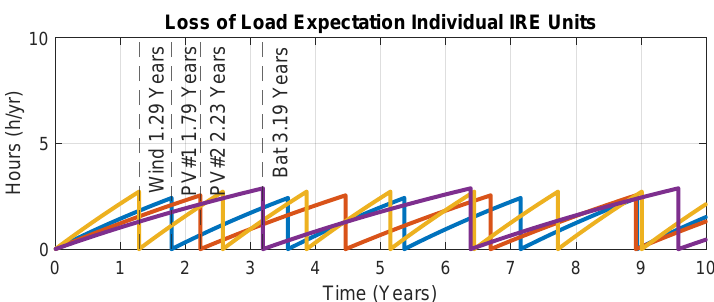
Figure 15. System risk response when the units are replaced in order to avoid violation of defined system risk limitations. 0